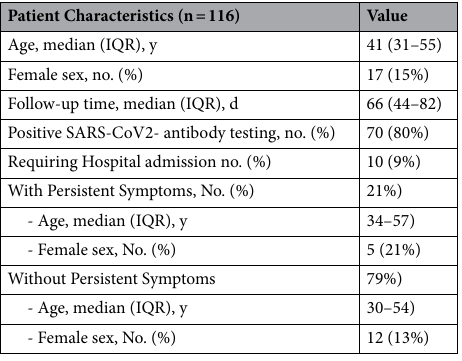
Table 1. Demographic and Clinical Characteristics of patients (n = 116).